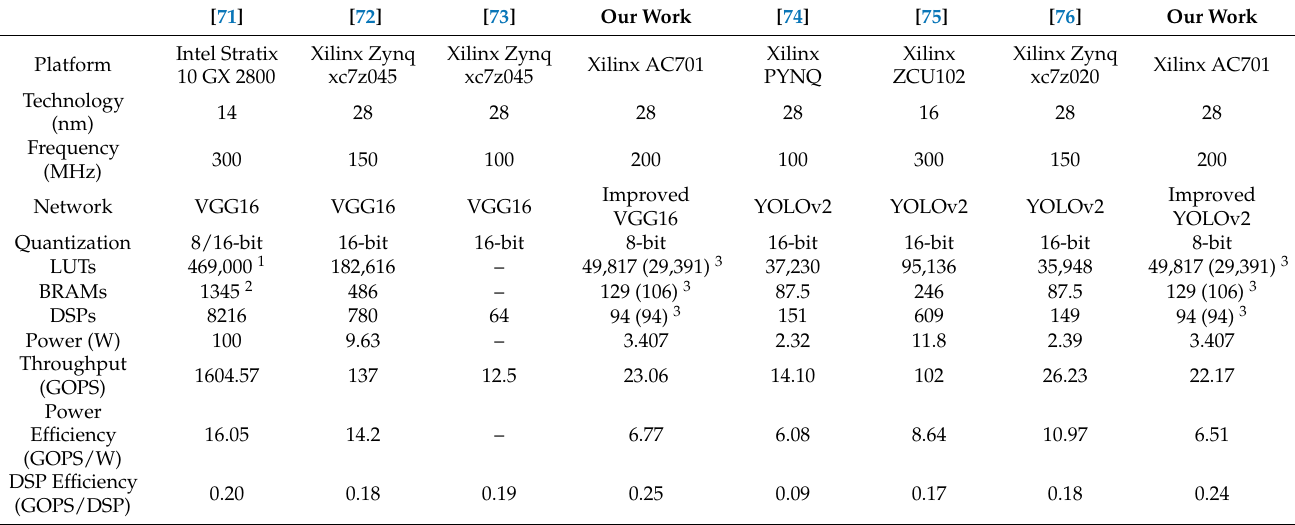
Table 3. Performance comparison of our work with previous